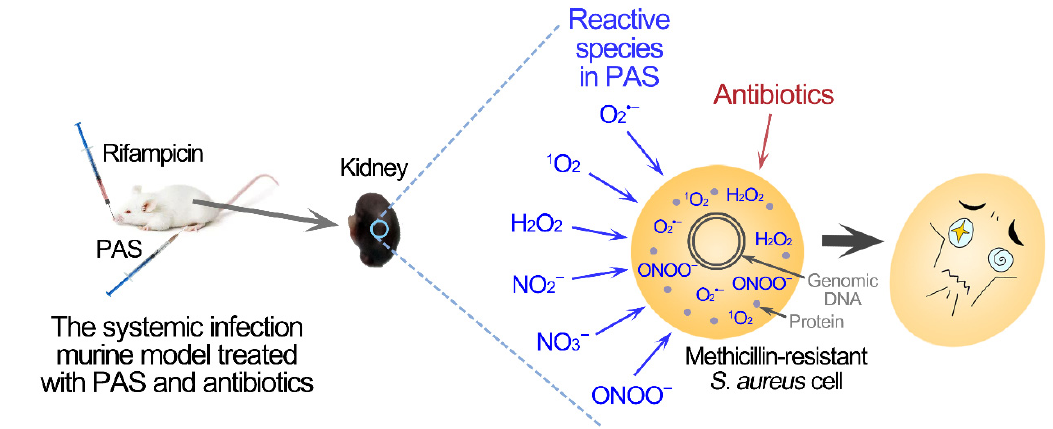
Figure 5. The systemic methicillin-resistant S. aureus infection treated with the combined treatment of PAS and antibiotics.